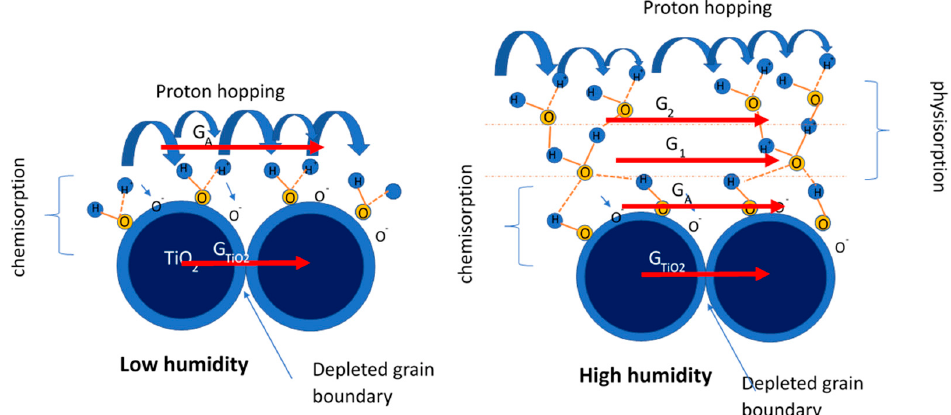
Figure 5. Simplified description of the contributions to charge transport phenomena for TiO 2 in a humid environment. The red arrows represent the current paths in the different layers and in the TiO 2 film.